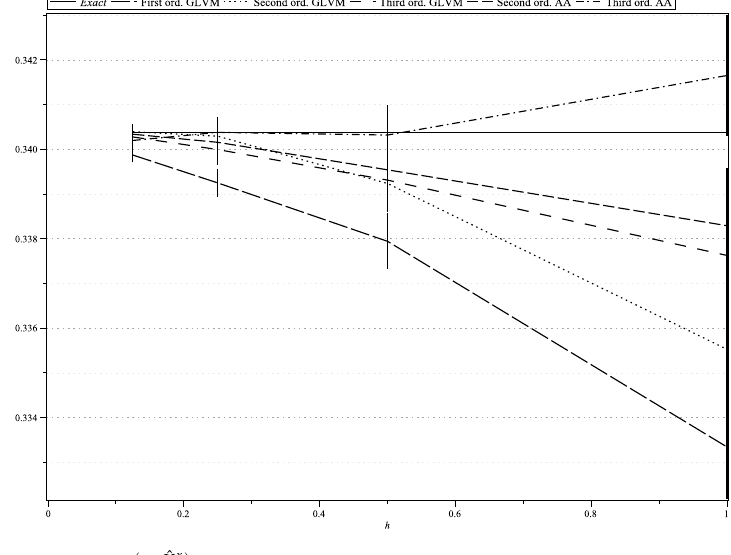
Figure 1. E e − ( 1/2 ˆ X x 1 ) as functions of h : σ = 0.8, θ = 0.5, β = 0.5, x 0 = 1.5.